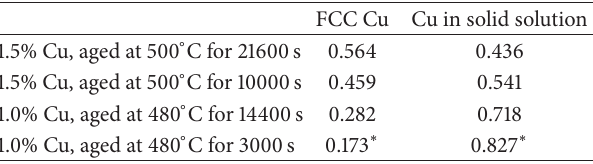
Table1:CalculatedfractionofFCCCopperprecipitatesandCopper atoms in the solid solution in 18CrNiMo7-6 carburizing steel with different heat treatment